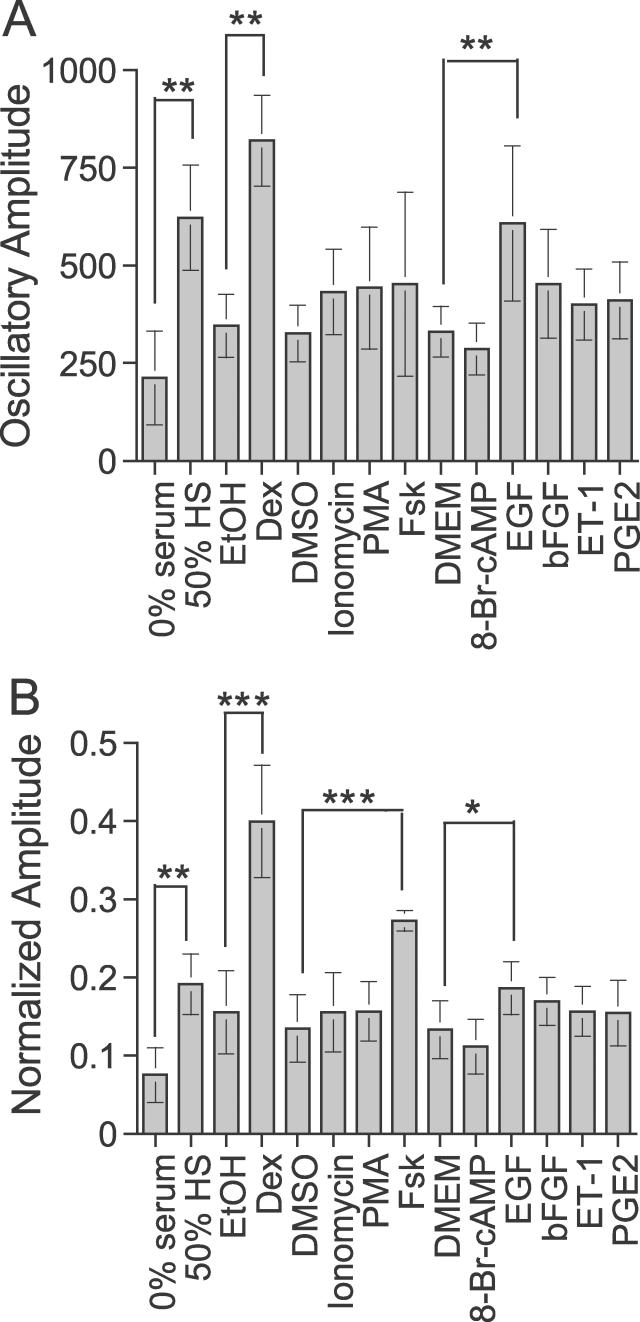
Histogram Representation of the Oscillatory Amplitude Calculations in Table 1
Error bars are ± S.D. *Statistical significance (p < 0.05) as compared to each control. **p < 0.005; ***p < 0.0005. (A) Absolute oscillatory amplitude. (B) Normalized oscillatory amplitude.